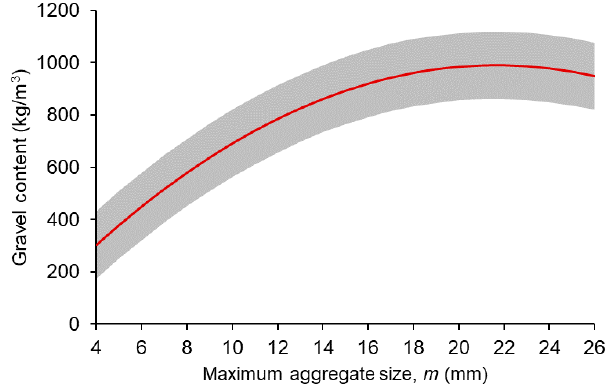
Figure 5. Coarse aggregate content versus maximum aggregate size.